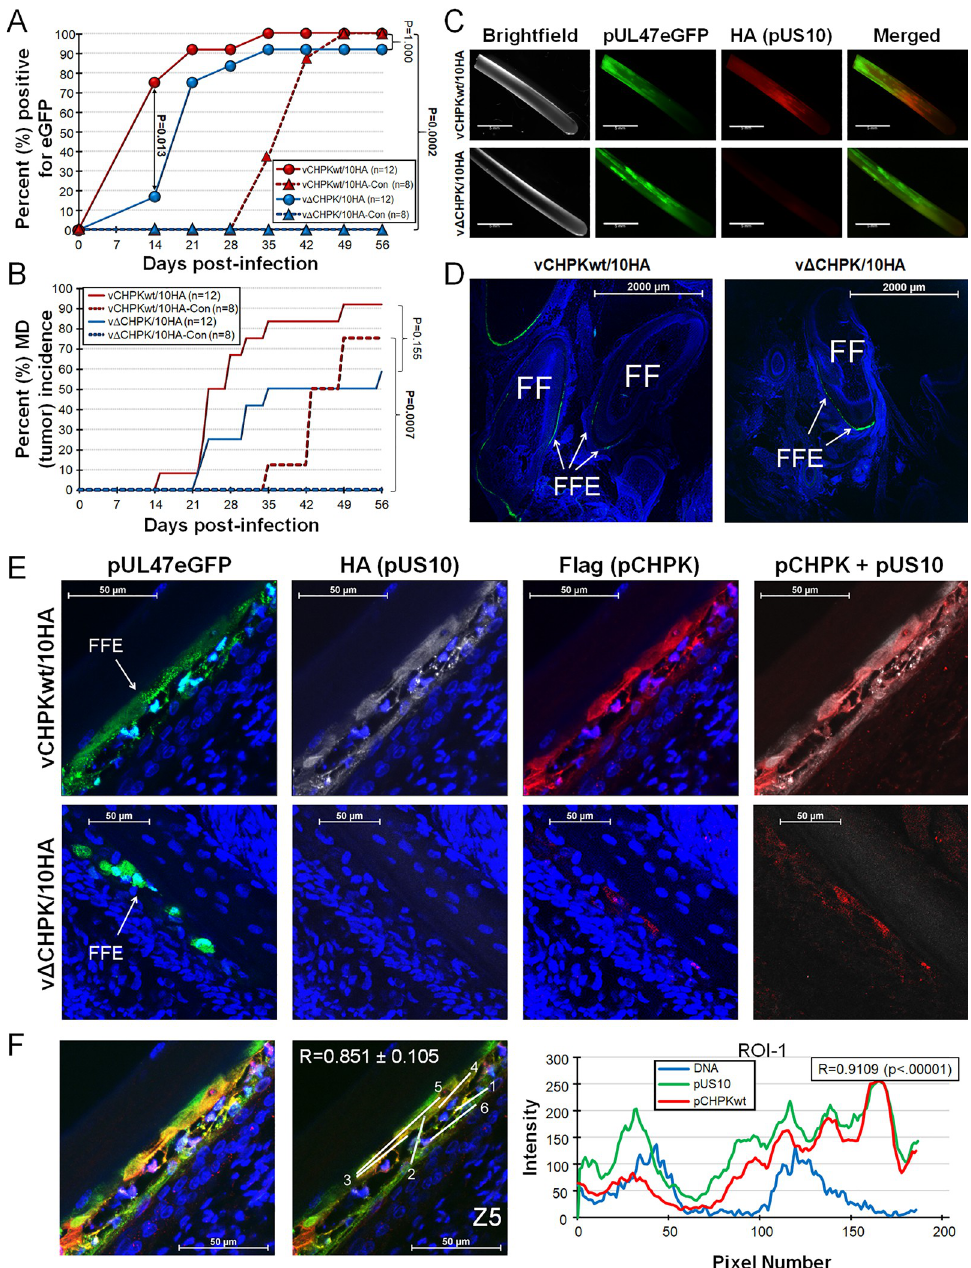
Fig 6. Horizontal transmission, MD incidence, and pUS10 expression of HA-tagged pUS10 rMDVs in chickens. PC chickens were infected with vCHPKwt/10HA or v Δ CHPK/10HA as described in the Materials & Methods. (A) Quantitative analysis of the percent of birds with virus positive FF (pUL47eGFP) over the course of the experiment. FFs were plucked from experimentally and naturally infected groups, visualized with a fluorescent stereoscope, and determined to be positive or negative for replication in FFs based on pUL47eGFP expression. There was no significant difference between the two groups in experimentally infected chickens using Fisher’s exact test ( P = 1.000), while v Δ CHPK/10HA was unable to horizontal transmit to contact (-Con) chickens that was significantly different to vCHPKwt/10HA contact chickens ( P < 0.001). (B) Total MD incidence was determined during both experimental and natural infection. There were no significant differences in the total number of chickens developing MD in experimentally infected chickens ( P = 0.155), while no chickens developed MD in v Δ CHPK/10HA contact chickens (v Δ CHPK/ 10HA-Con) that was significant using Fisher’s exact test ( P < 0.001). (C) Feathers were plucked from experimentally infected chickens at 28 days pi and stained for pUS10 with the anti-HA antibody showing aberrant pUS10 expression in v Δ CHPK/10HA-infected feathers. Scale bars are 5 mm. (D) Representative images of skin/feather tissues cryosections